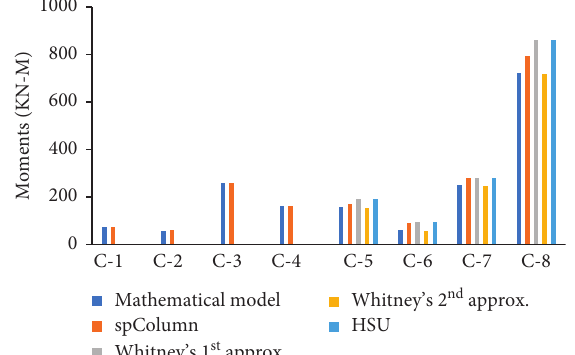
Figure 12: Moment capacity comparison for uniaxial columns